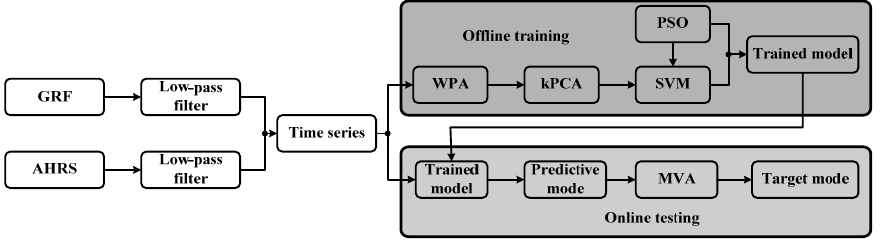
( e ) Figure 12. Experiments for locomotion mode identification. ( a ) Stair descent; ( b ) Stair ascent; ( c ) Ramp descent; ( d ) Ramp ascent; ( e ) Level-ground walking. Each human subject performed two kinds of experiments. The first kind of experiment was to walk in different locomotion modes, i.e., stair descent, stair ascent, ramp descent, ramp ascent and level-ground walking. Each locomotion mode included 10 experimental trials for one human